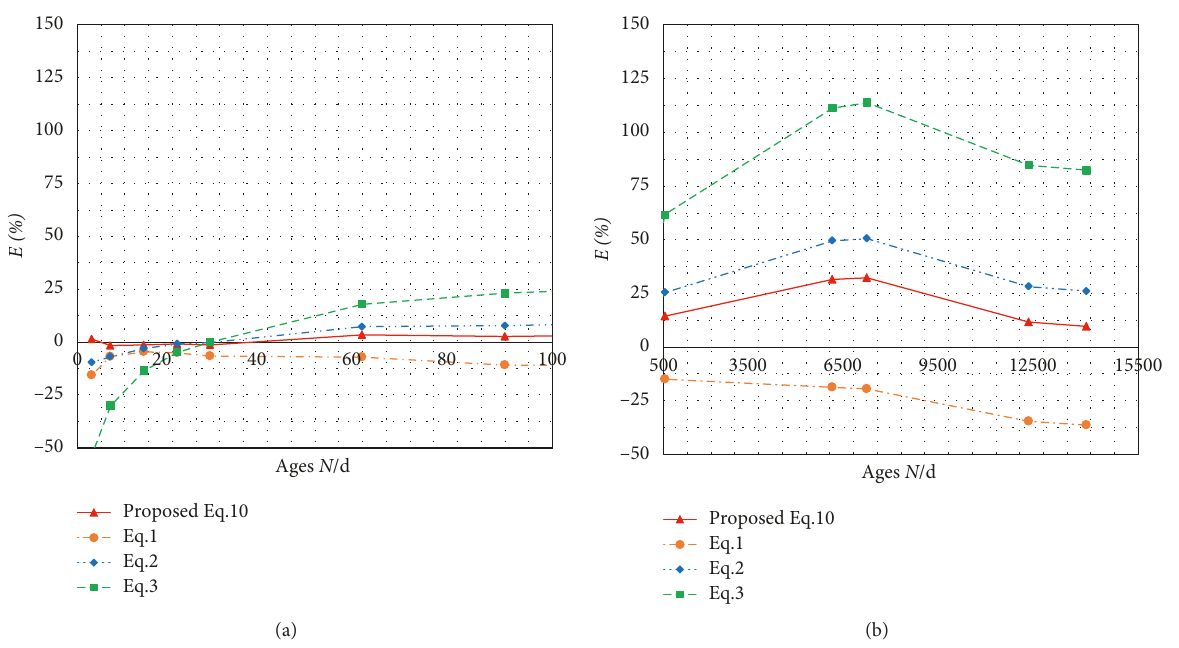
Figure 16: Relative deviation (E) distribution between the predicted results of different models and those measured. (a) Experimental data. (b) Engineering